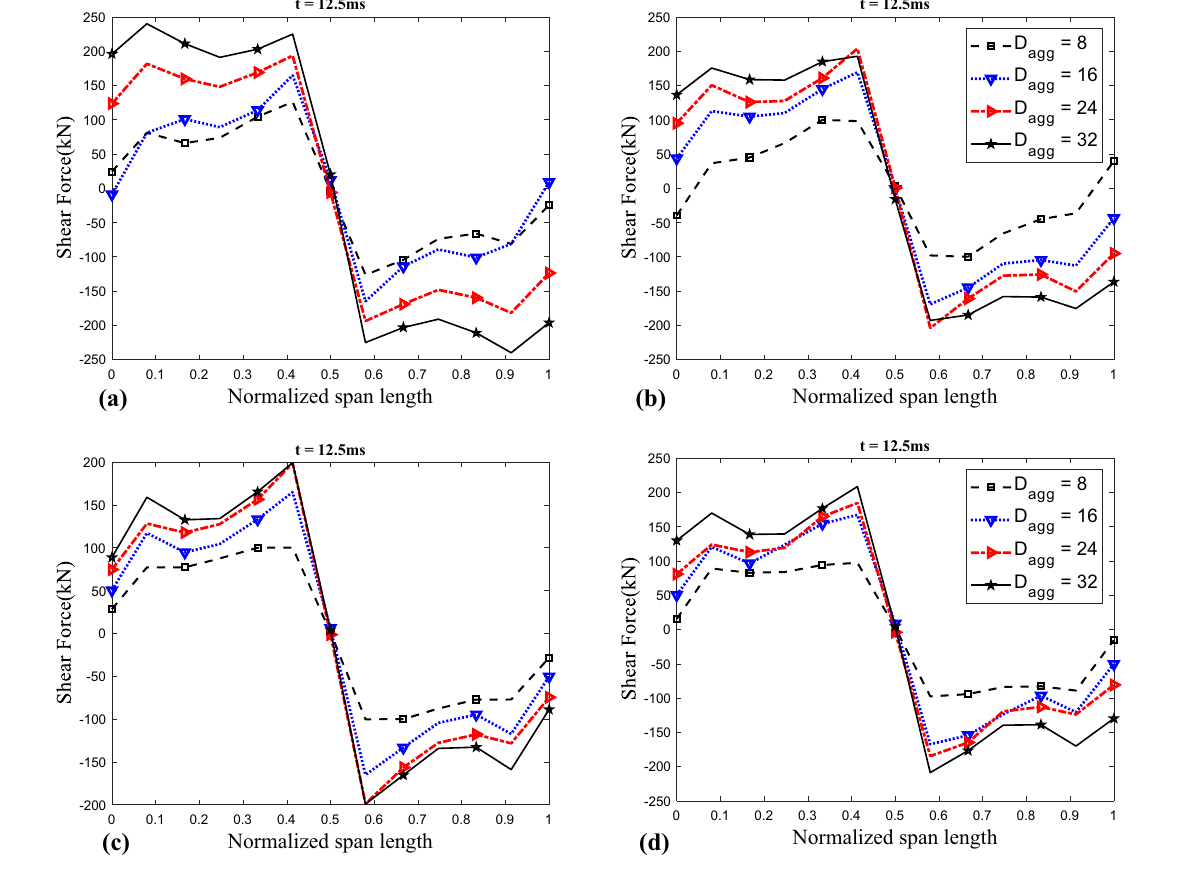
Fig. 14 Shear force diagrams at t = 12.5 ms for a CM1, b CM2, c CM3 and d CM4